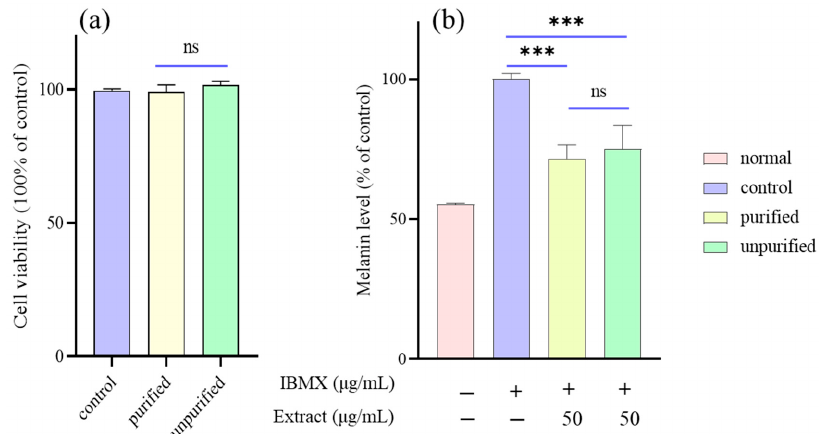
Figure 2. ( a ) Cell viability and ( b ) melanin content in B16/F10 cells treated with DCM-PLS purified and unpurified by activated carbon. *** p -value < 0.001 was compared with IBMX induced group. Normal means that the blank group was not stimulated with IBMX. ns: not significant ( p >